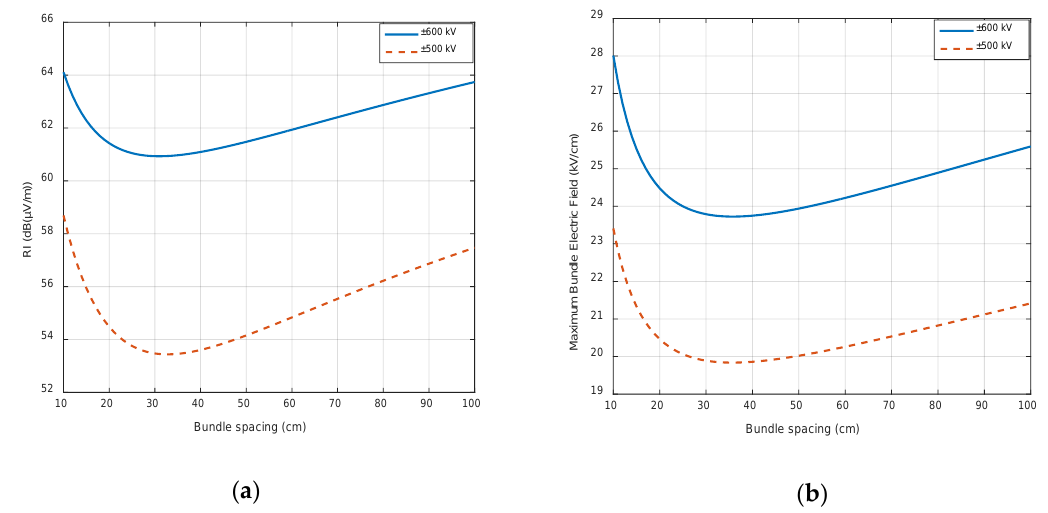
Figure 6. Parametric sweeps: ( a ) RI as a function of bundle spacing; ( b ) Maximum bundle electric field ( g max ) as a function of bundle spacing.